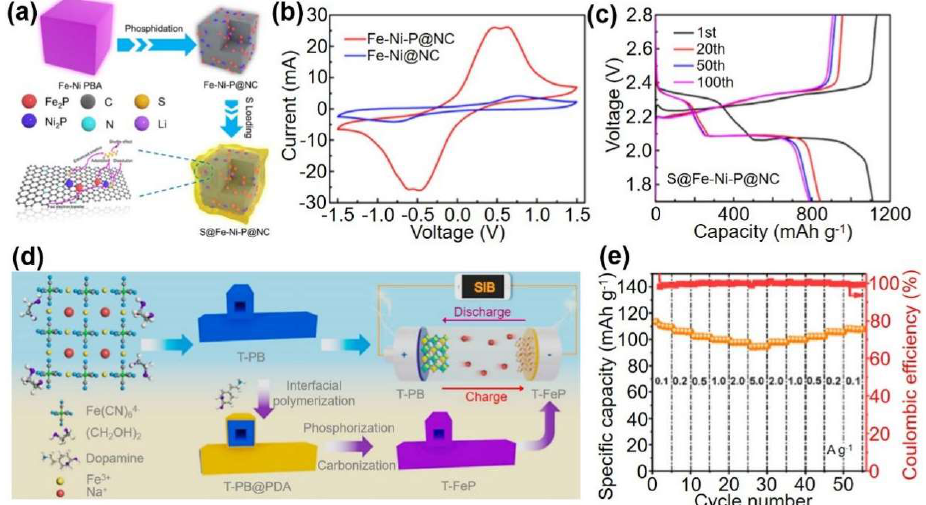
Figure 7. ( a ) Schematic diagram of the preparation of S@Fe-Ni-P@NC composites. ( b ) CV profiles of Fe-Ni-P@NC and Fe-Ni@NC in symmetric cell. ( c ) Galvanostatic charge–discharge curves.[20] ( d ) Schematic diagram for the synthesis of T-PB and T-FeP. ( e ) Rate capability at different current densities from 0.1 to 5.0 A g −1 . Ref. [22] Copyright Journal of Power Sources, Elsevier.